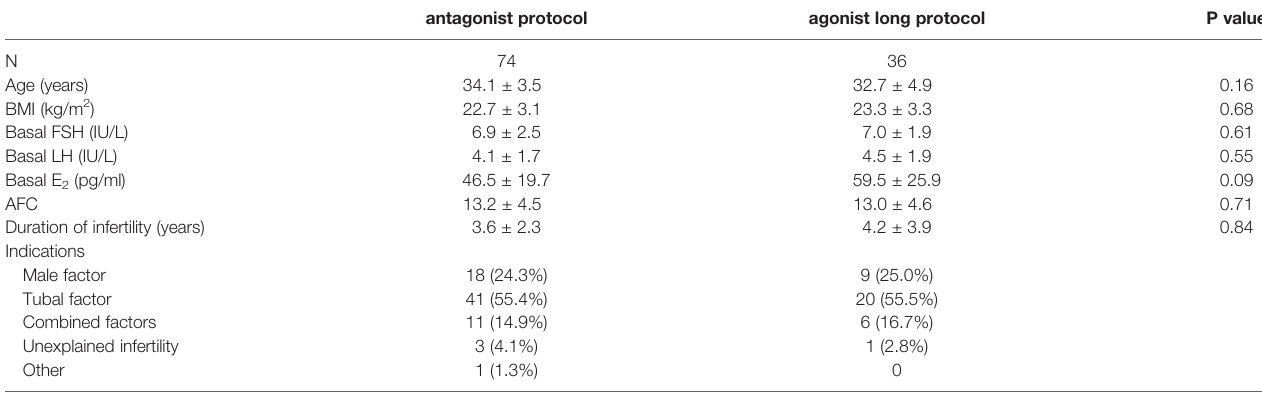
TABLE 1 | Baseline patient characteristics and demographic